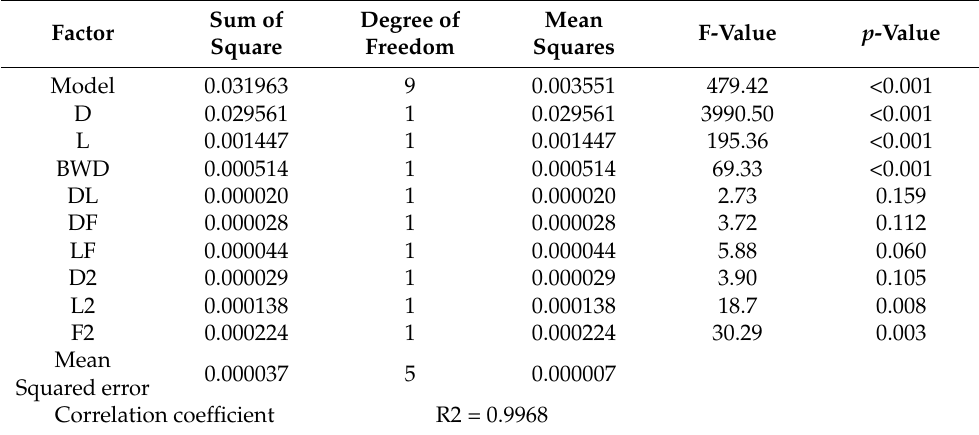
Table 6. Variance analysis of the gap (G) between the top die and the bottom die.